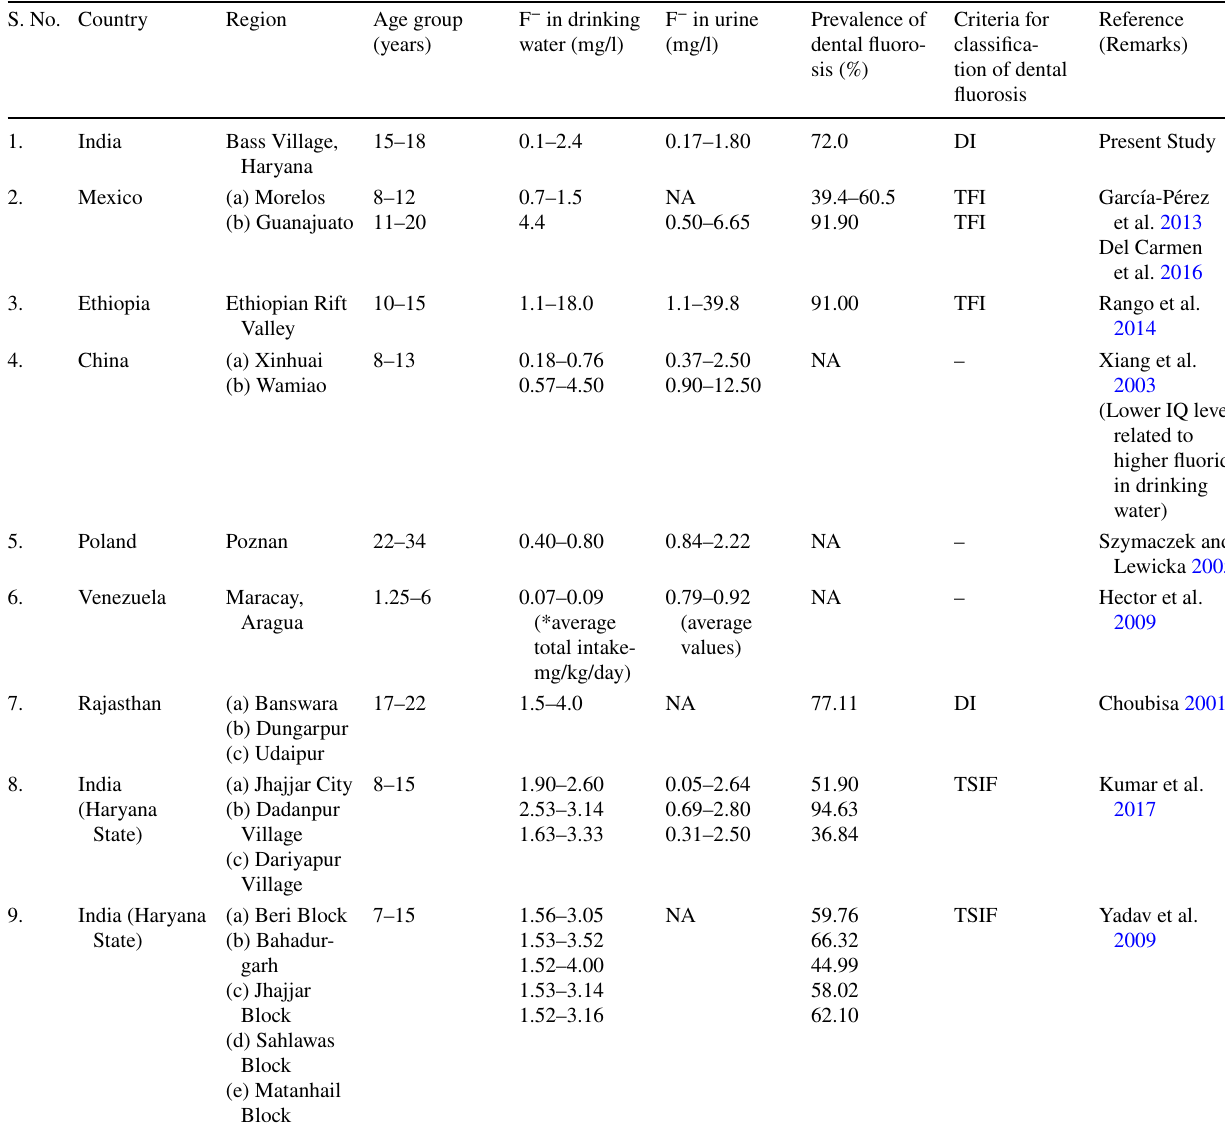
DI Dean’s Index, TFI Thylstrup and Fejerskov Index, TSIF Tooth Surface Index of Fluorosis (Horowitz et al. 1984), NA not analysed